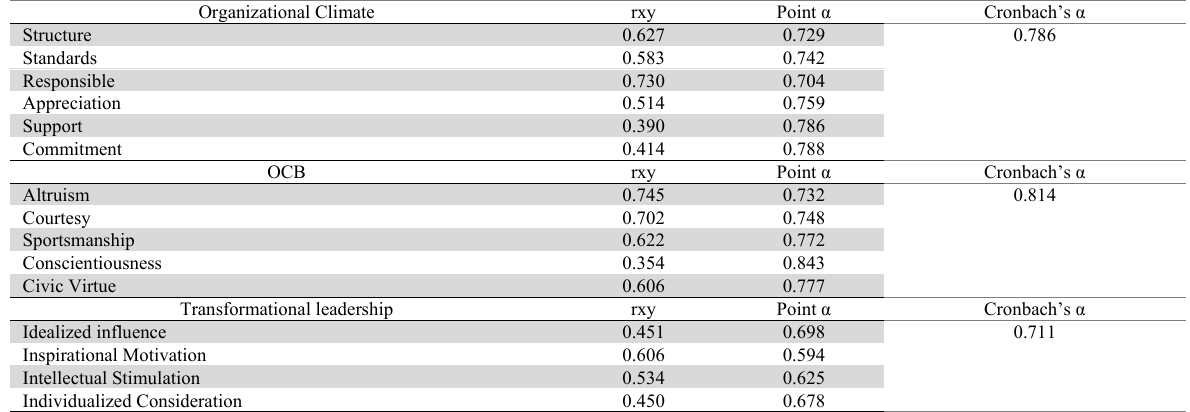
Test the validity of the independent